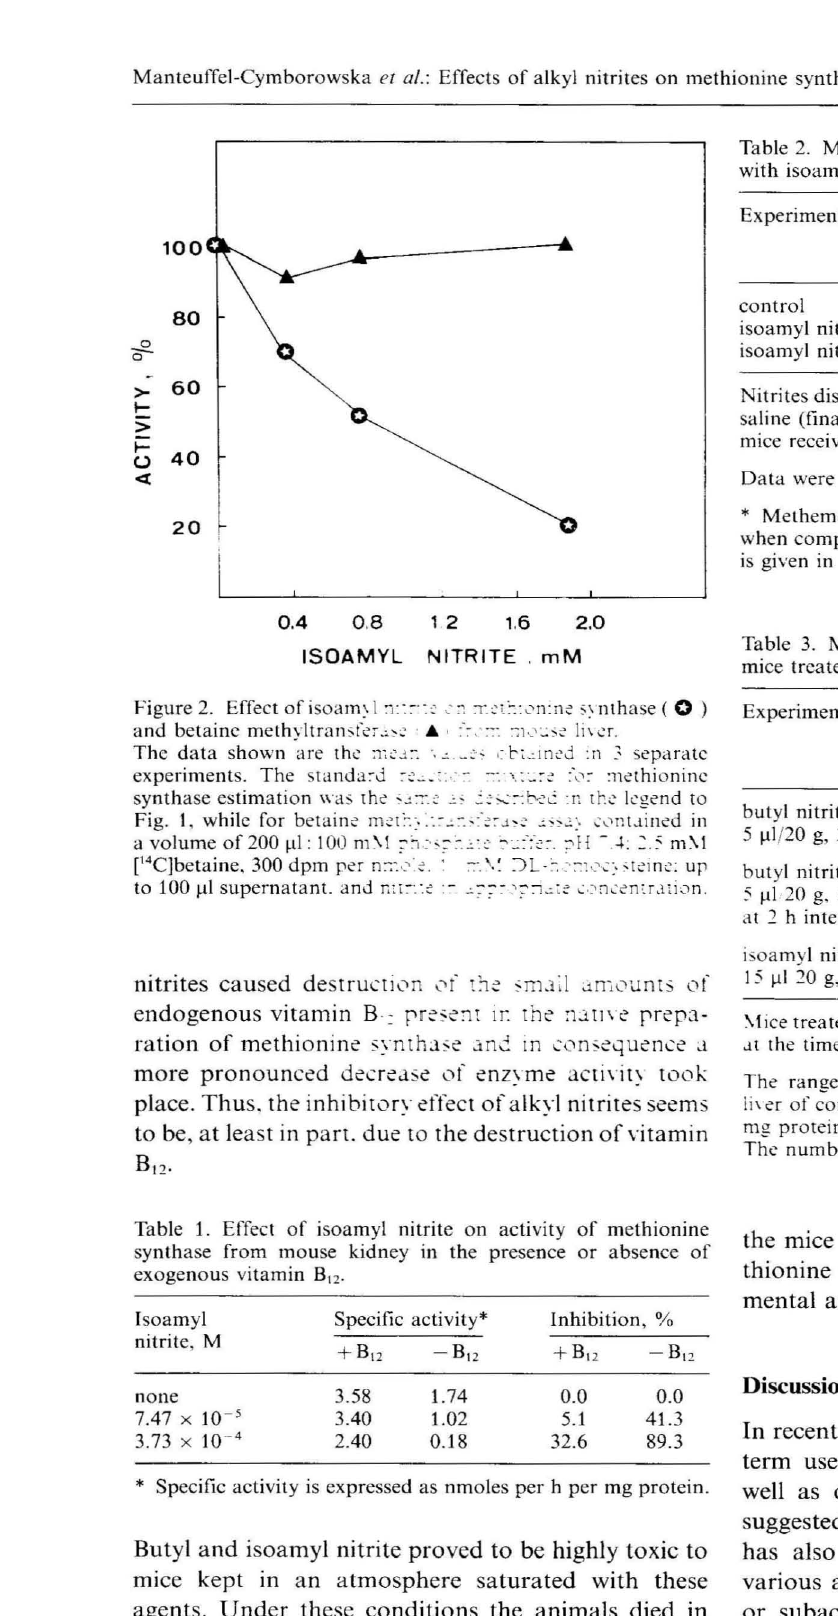
Table 3. Methionine synthase activity in kidney and liver of mice treated with butyl or isoamyl